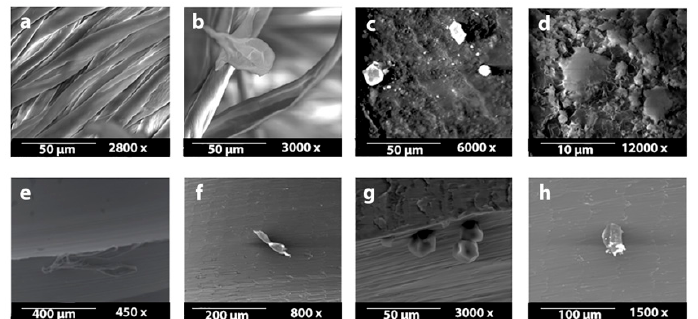
Figure 2. Surface contamination of the machined OMIs. From left to right: aluminum particle (Al), carbon particle (C), and plastic particle (Polyvinyl Chloride PVC).